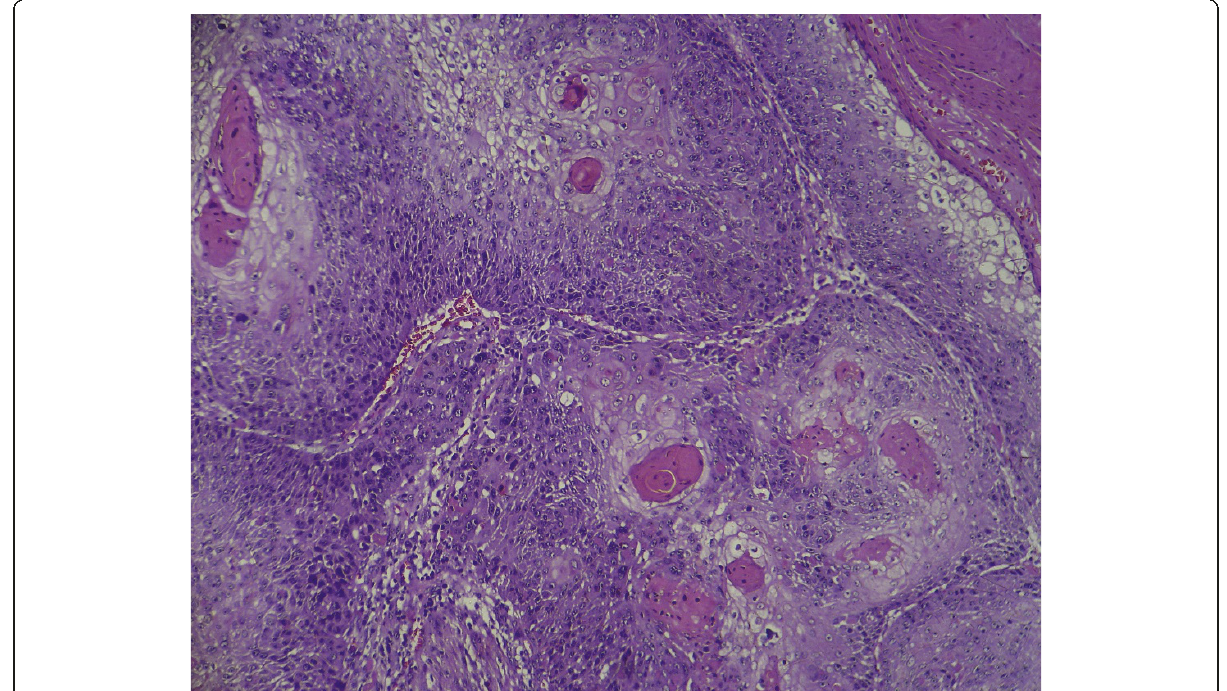
Figure 1 Primary tumor; solid tumor nests in a case of head and neck squamous cell carcinoma in primary location .